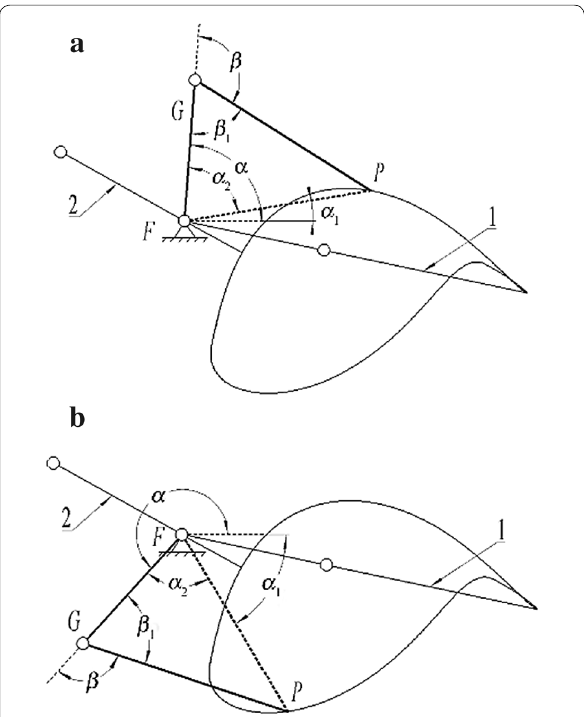
Figure 8 Schematic of the two limit positions of the link motion: a the endpoint moves from the farthest to the nearest position of the trajectory; b the endpoint moves from the nearest to the farthest position. 1 and 2 indicate the link states in the farthest and nearest limit positions,